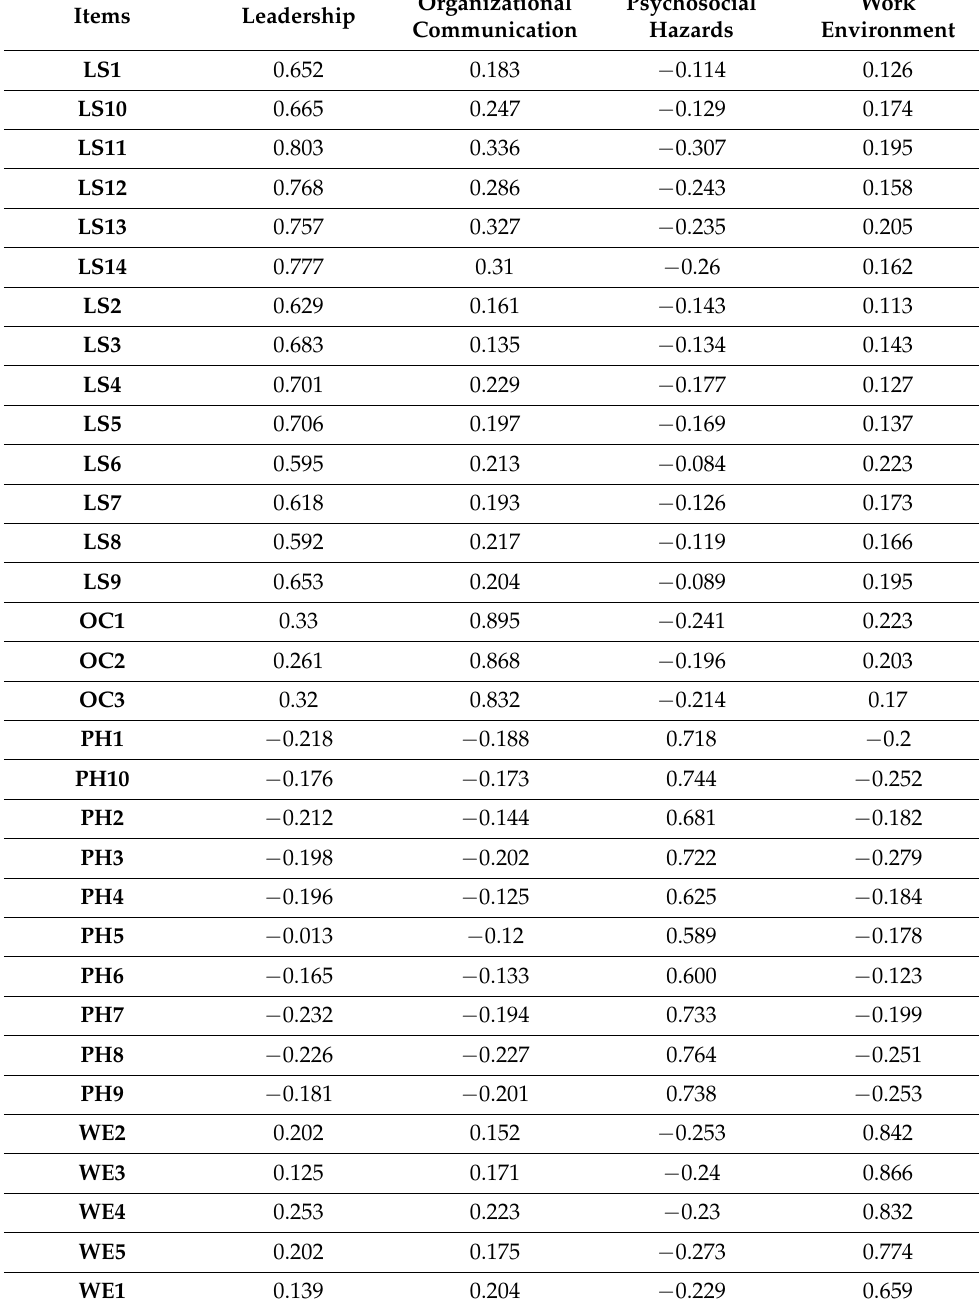
Table 5. Cross-loading outcomes of discriminate validity.